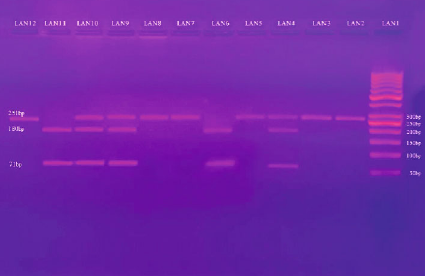
Figure 1: The products of TNF- α promoter gene after digestion by BbsI restriction enzyme on gel electrophoresis. LAN (1): 50 bp ladder; LAN (2, 3, 5, 7, 8, and 12): TT genotype; LAN (4, 6, 9, and 10): TC genotype; LAN (6 and 11): CC